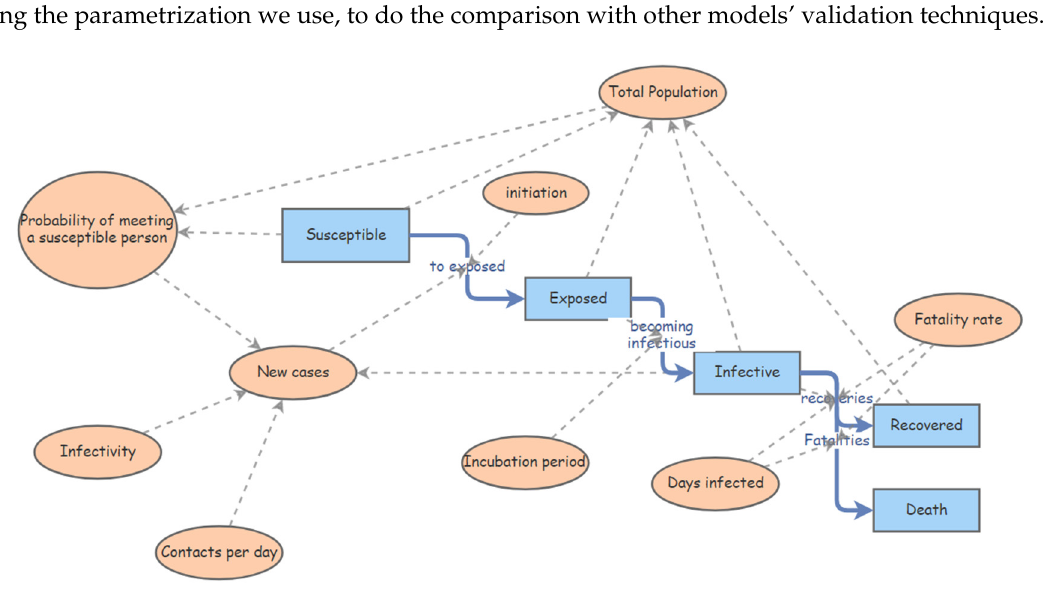
Figure 2. First preliminary System Dynamics SEIRD (Susceptible, Exposed, Infective, Recovered and Deceased)